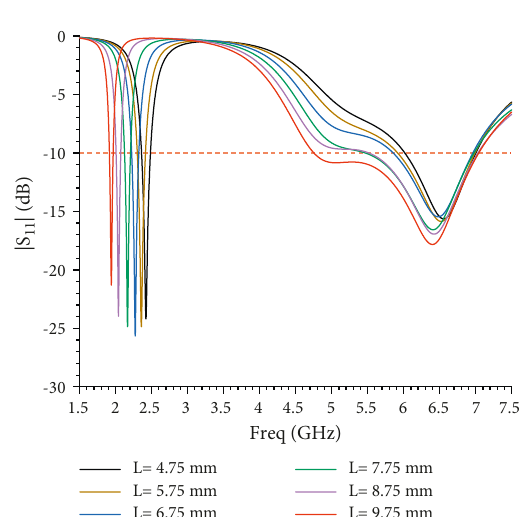
Figure 13: Effect of protruding stub length on the reflectance